Question: Write a caption explaining this figure to a reader.
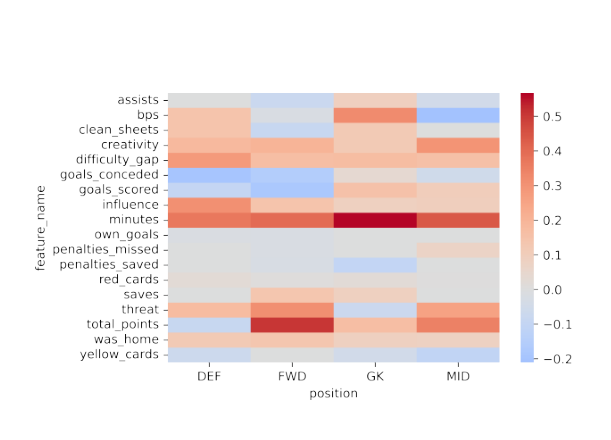
Answer: Heatmap of Ridge Regression coefficients. Models have the same regularization strength. Warm colors represent positive coefficients and vice versa.